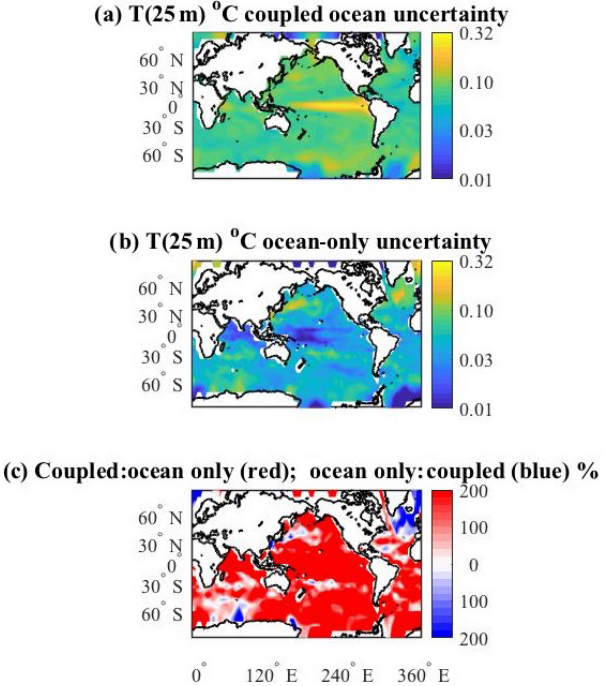
Figure 13. (a) Same as Fig. 3. (b) Maps of 2 standard deviations for representing uncertainty for December of the 10th year of the ocean-only simulation. (c) Ratio of a : b , with coupled uncertainty in red shades and ocean-only uncertainty in blue shades. and coupled members have the same ocean initial conditions. For each simulation, Z 1 yr , the average difference for a given year is calculated. Table 3 column 2 gives the average over the 30 pairs for each year and column 3 is the standard de- viation over the 30 pairs. The values show a steady increase in the spread through year 8, and then a small drop in year 9. The variance across the ensemble (column 3) indicates that for the first 5 years the spread increases and between years 6 and 9 the variance is approximately the